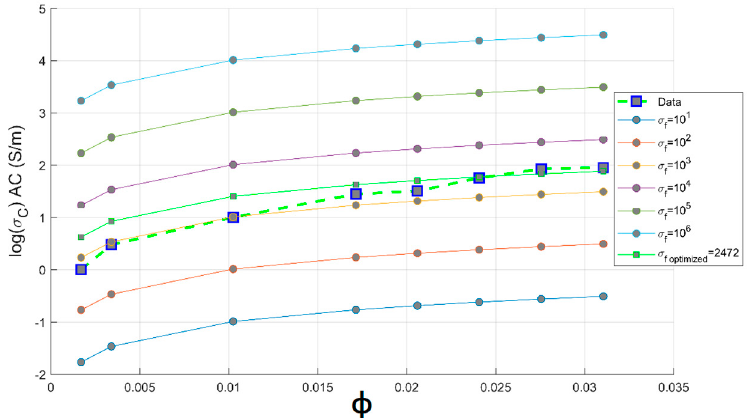
Figure 4. Theoretical and experimental plots of conductivity against volume fraction of CNTs based on the Bueche model for PC-CNT conductive composites.